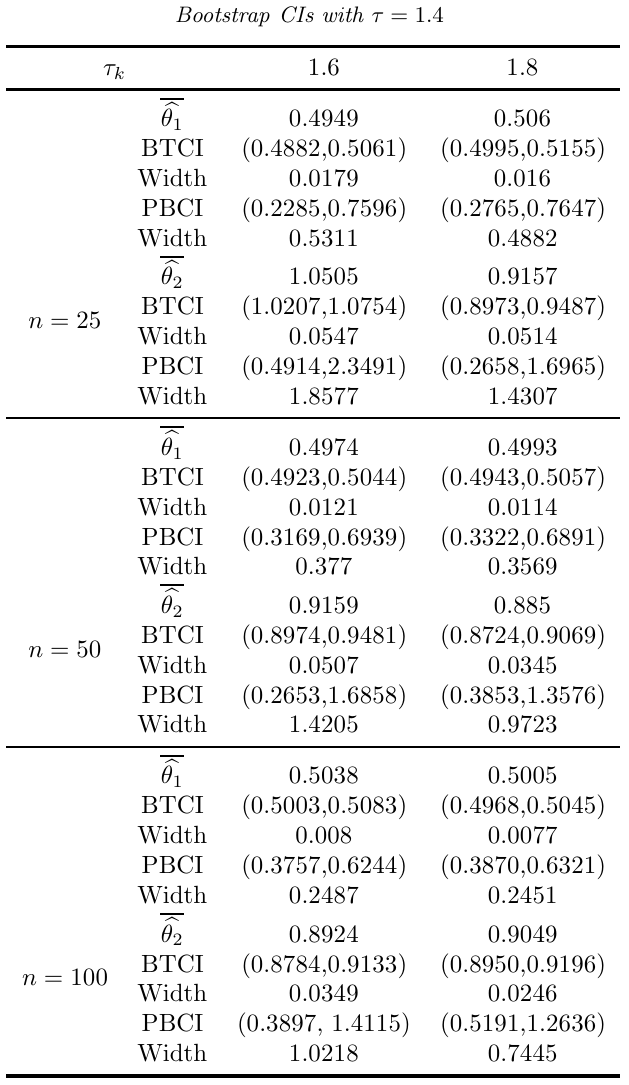
Bootstrap CIs with τ = 1 .